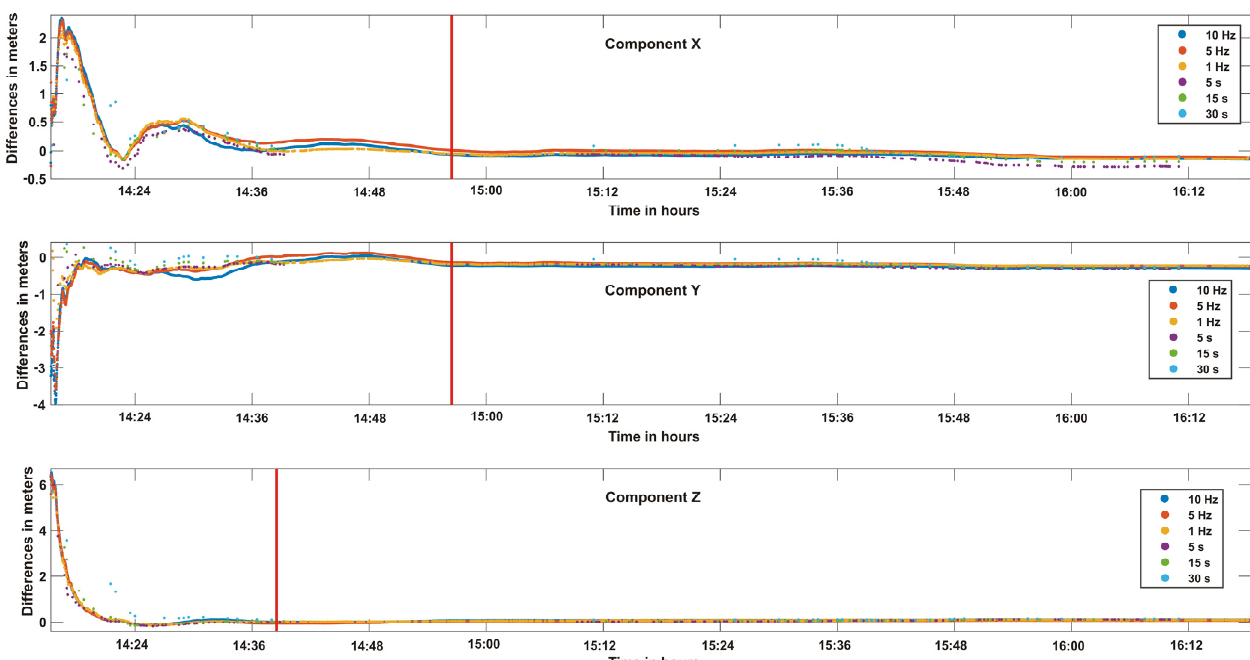
Figure 16. Convergence time achieved for solutions of the PPP method in static mode.